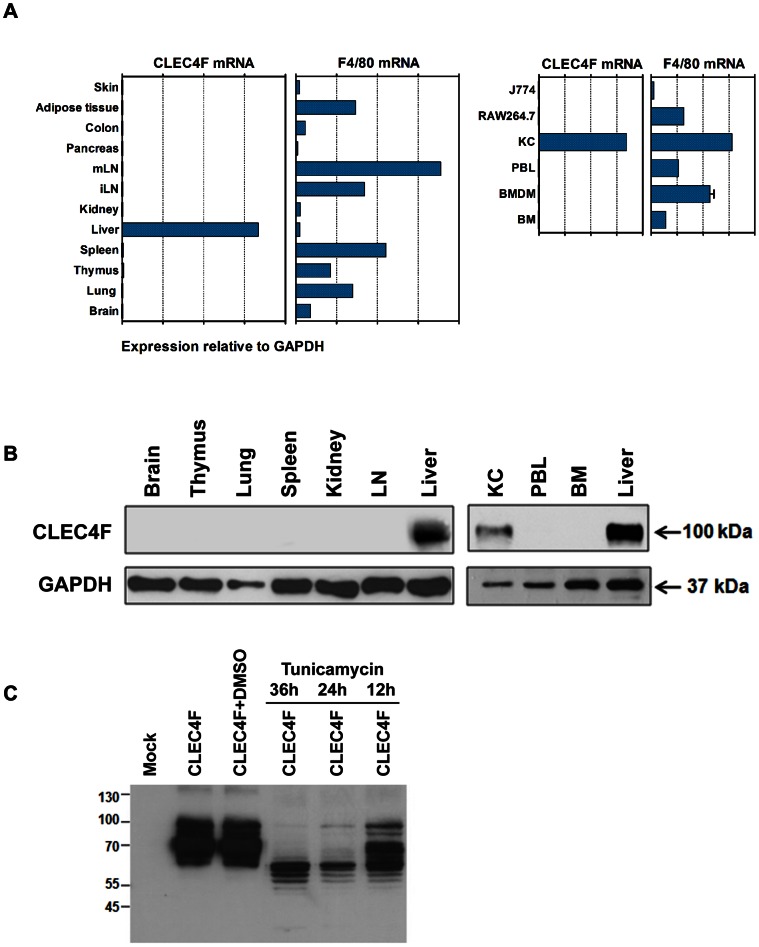
The expression and distribution of CLEC4F.(A) Tissue distribution of CLEC4F transcripts were analyzed by qRT-PCR. F4/80 is the pan macrophage marker. (B) The protein expression of CLEC4F was examined by Western blot. GAPDH was used as internal control. (C) CLEC4F is a glycoprotein. The pFLAG-CMV-2/CLEC4F-transfected 293T cells were treated with tunicamycin at 1.5 µg/ml for indicated time periods to inhibit N-linked glycosylation, and the molecular weight of CLEC4F was analyzed by Western blot. DMSO is the vehicle control. Mock indicates 293T cells transfect with pFLAG-CMV-2. mLN, mesenteric lymph node; iLN, inguinal lymph node; KC, Kupffer cells; PBL, peripheral blood leukocytes; BM, bone marrow cells; BMDM, bone marrow derived macrophages.